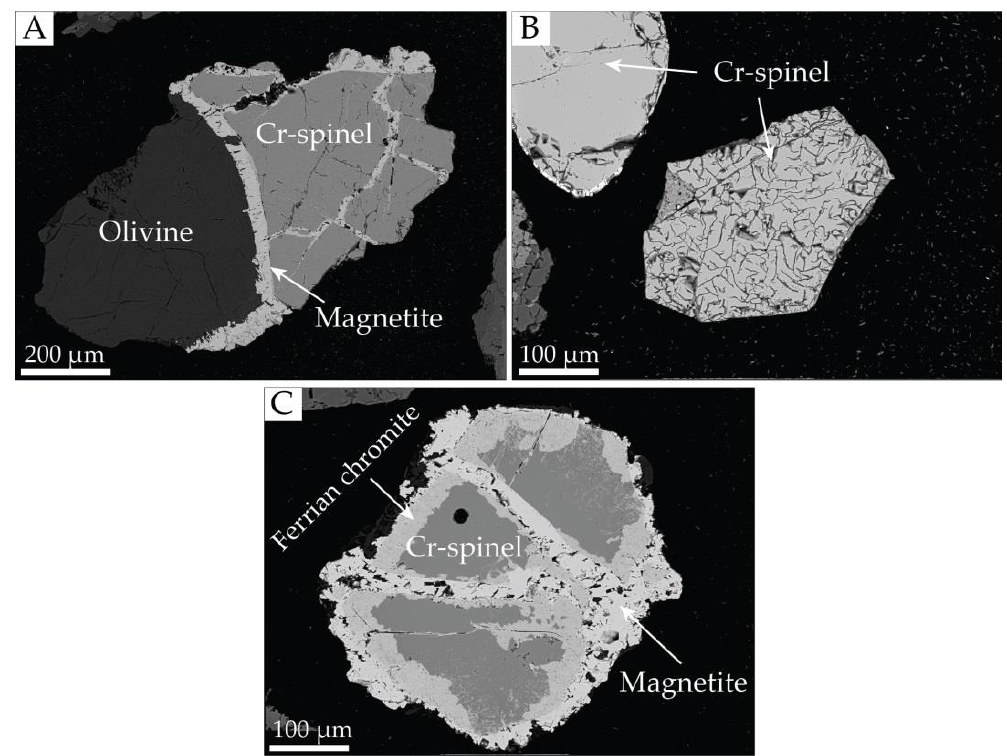
Figure 5. ( A ) Chromian spinel in paragenesis with magnetite and serpentinized olivine (sample JP 08); ( B ) homogenous grains of chromian spinel (sample JP 10); ( B , C ) altered grains of